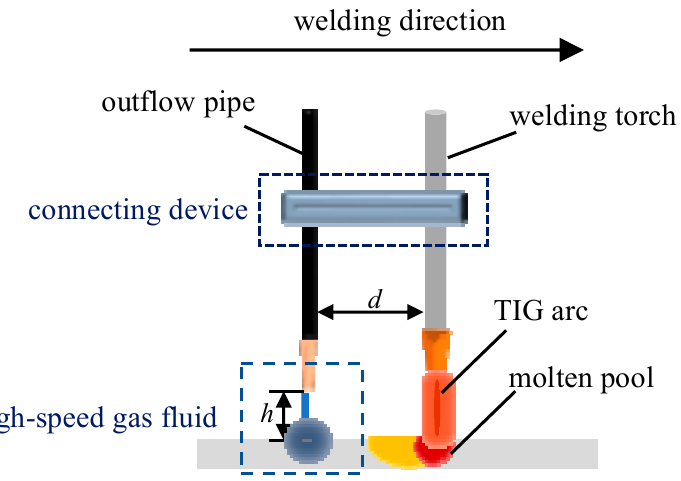
Figure 1. Schematic diagram of the stress and distortion controlled by the trailing of the hybrid high-speed gas fluid field during welding.